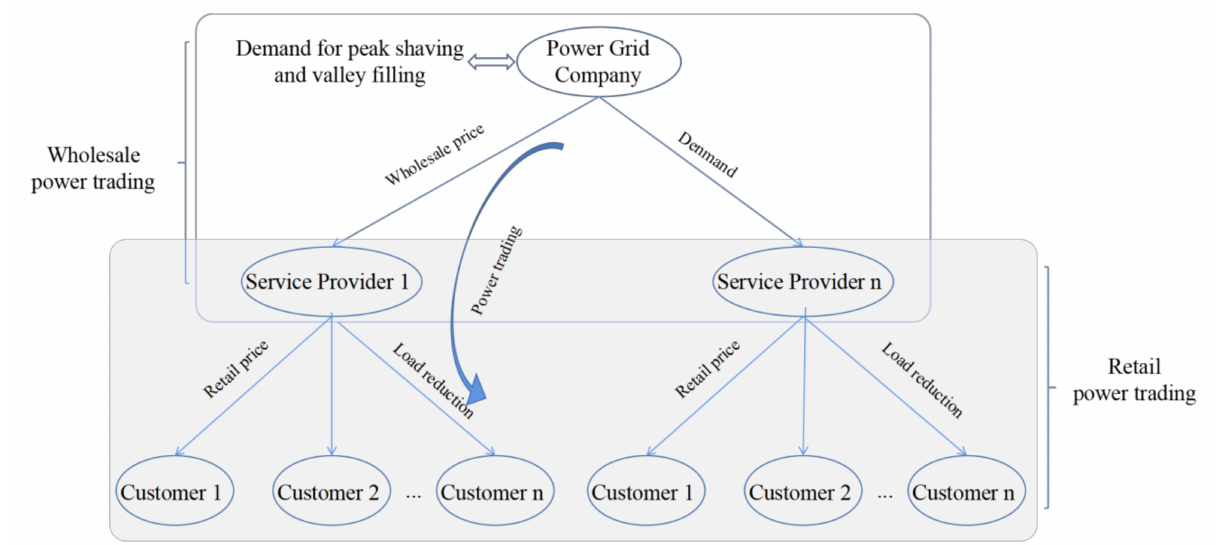
Figure 1. Power trading model considering the service